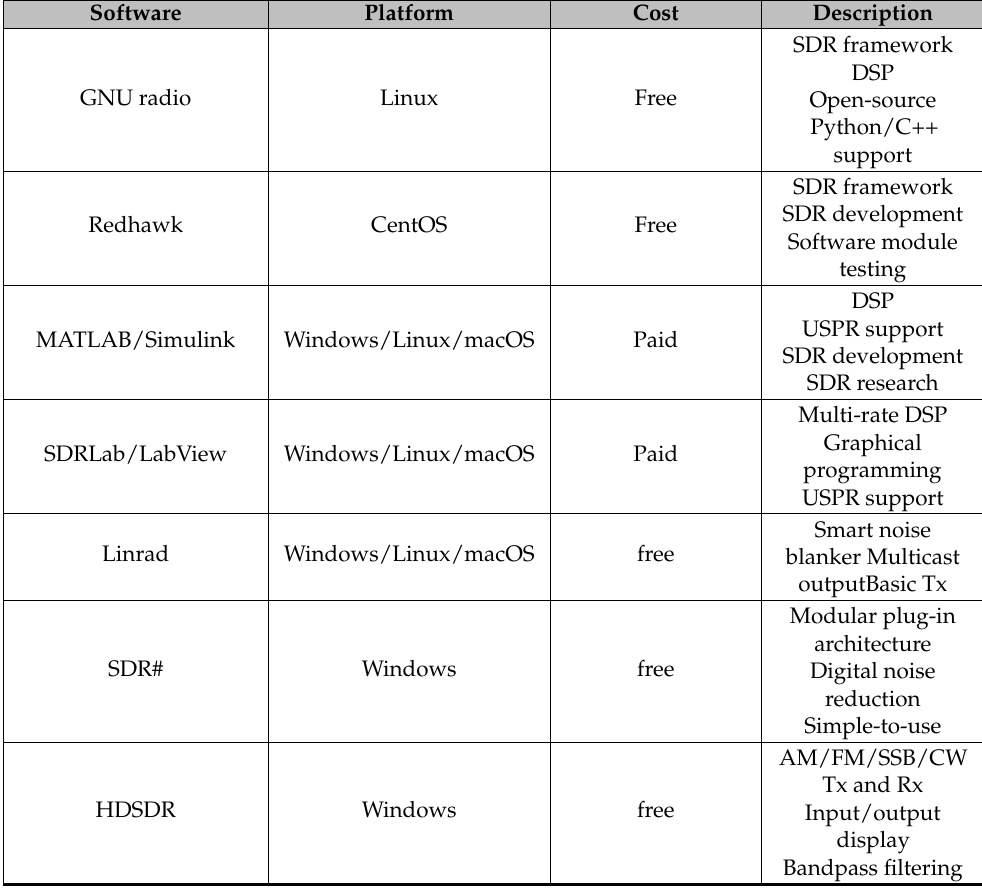
Table 3. SDR software platforms suitable for development and